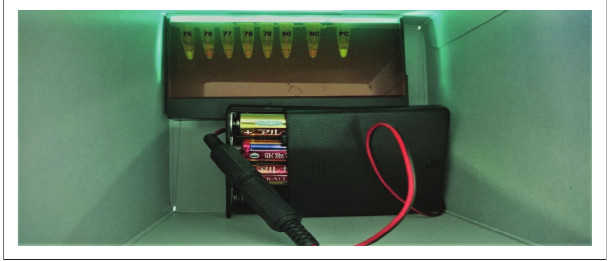
FIGURE 1: Visualisation of dry repetitive insertion mobile element loop- mediated isothermal amplification using battery-operated LED light. Positive and negative samples turn green and orange, respectively, under LED